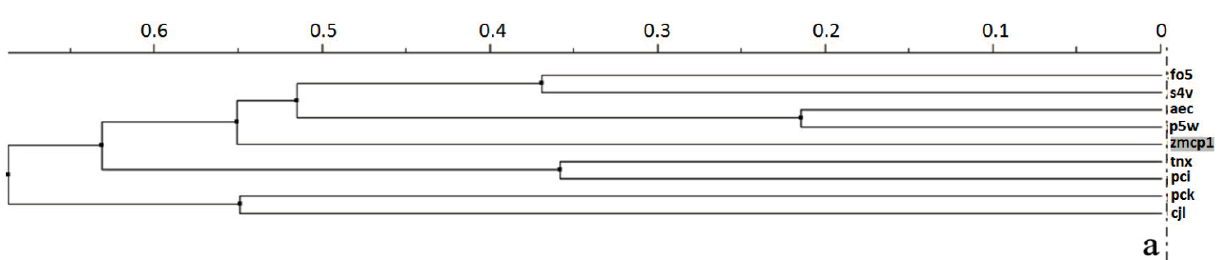
Figure 1. ( a ) Phylogenetic analysis of nine proteins; ( b ) Sequence alignment of zmCP1 and KDEL-tailed cysteine endopeptidase (PDB ID 1S4V, sequence identity 59%), 2FO5, barley cysteine endoprotease B isoform 2 (EP-B2) (PDB ID 2FO5, sequence identity 56%); 3P5W, Actinidin (PDB ID 3P5W, sequence identity 55%); 1AEC: Actinidin (PDB ID 1AEC, sequence identity 53. Red represent identity, and yellow represent